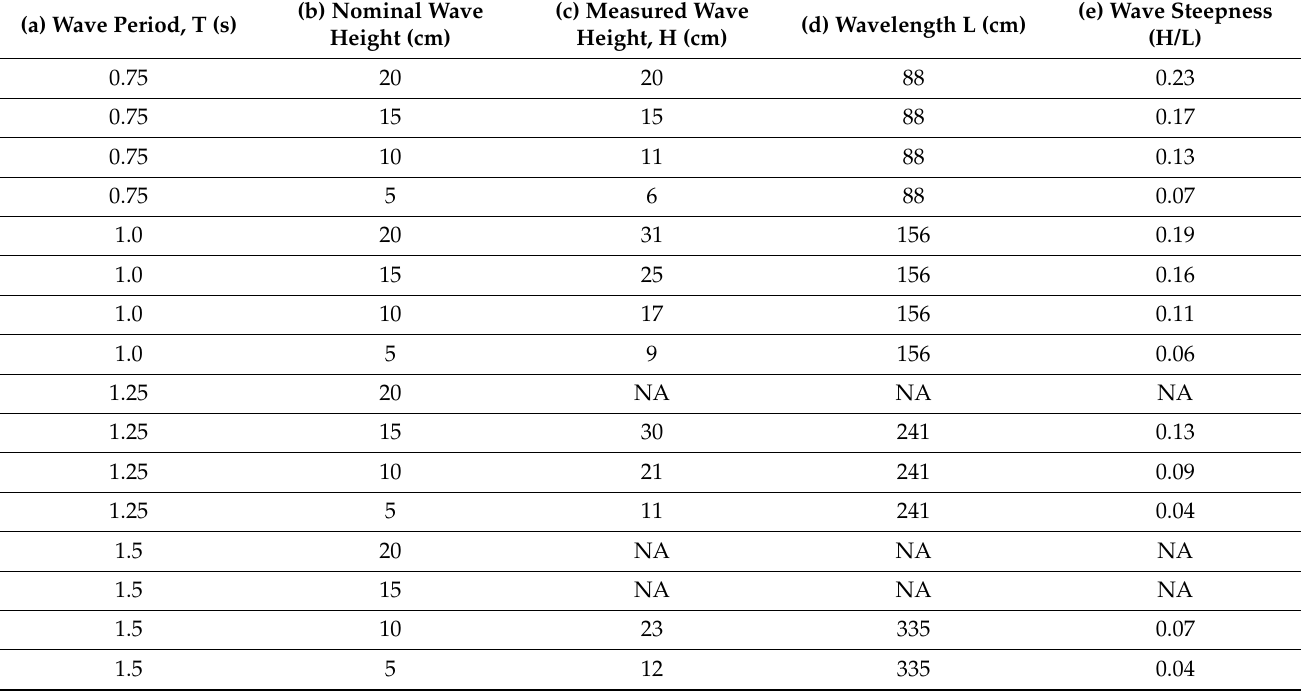
Figure 5. The wave energy converter and its mechanical behavior (schematics not to scale). ( a , b , c ) Schematics of the OWEC on the water surface following the surface profile of the water waves. ( d , e , f ) Photographic images of the OWEC on the water surface and its responses to the wave motion, following the surface profile. Table 1. The nominal and measured parameters of waves. Water depth was fixed at H = 97 cm throughout the tests. (a) The wave period was determined by the period of the paddle in the wave flume. (b) Nominal wave heights were chosen and entered as the required heights to the LabVIEW program. (c) The measured wave height, H, is the real wave height, measured by the wave probes. (d) Wavelength, L, was determined by the wave dispersion relationship [54]. (e) The wave steep- ness (H/L) was the quotient of measured wave height to wavelength. “NA” indicates instances where the wave parameter was not well defined due to wave breaking and the subsequent genera- tion of harmonics.